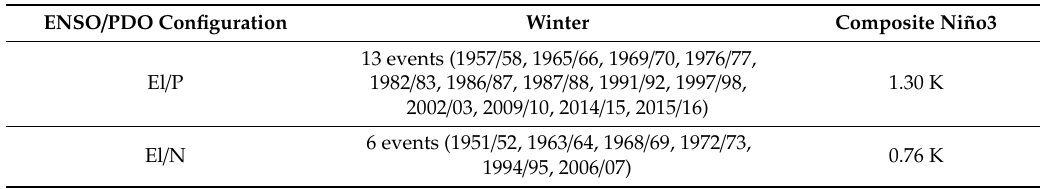
Table 1. The El Niño–Southern Oscillation (ENSO) events classified by the Pacific Decadal Oscillation (PDO) phases in observations. El / La denotes El Niño / La Niña events in the first column. P / N denotes the positive / negative phases of the PDO.